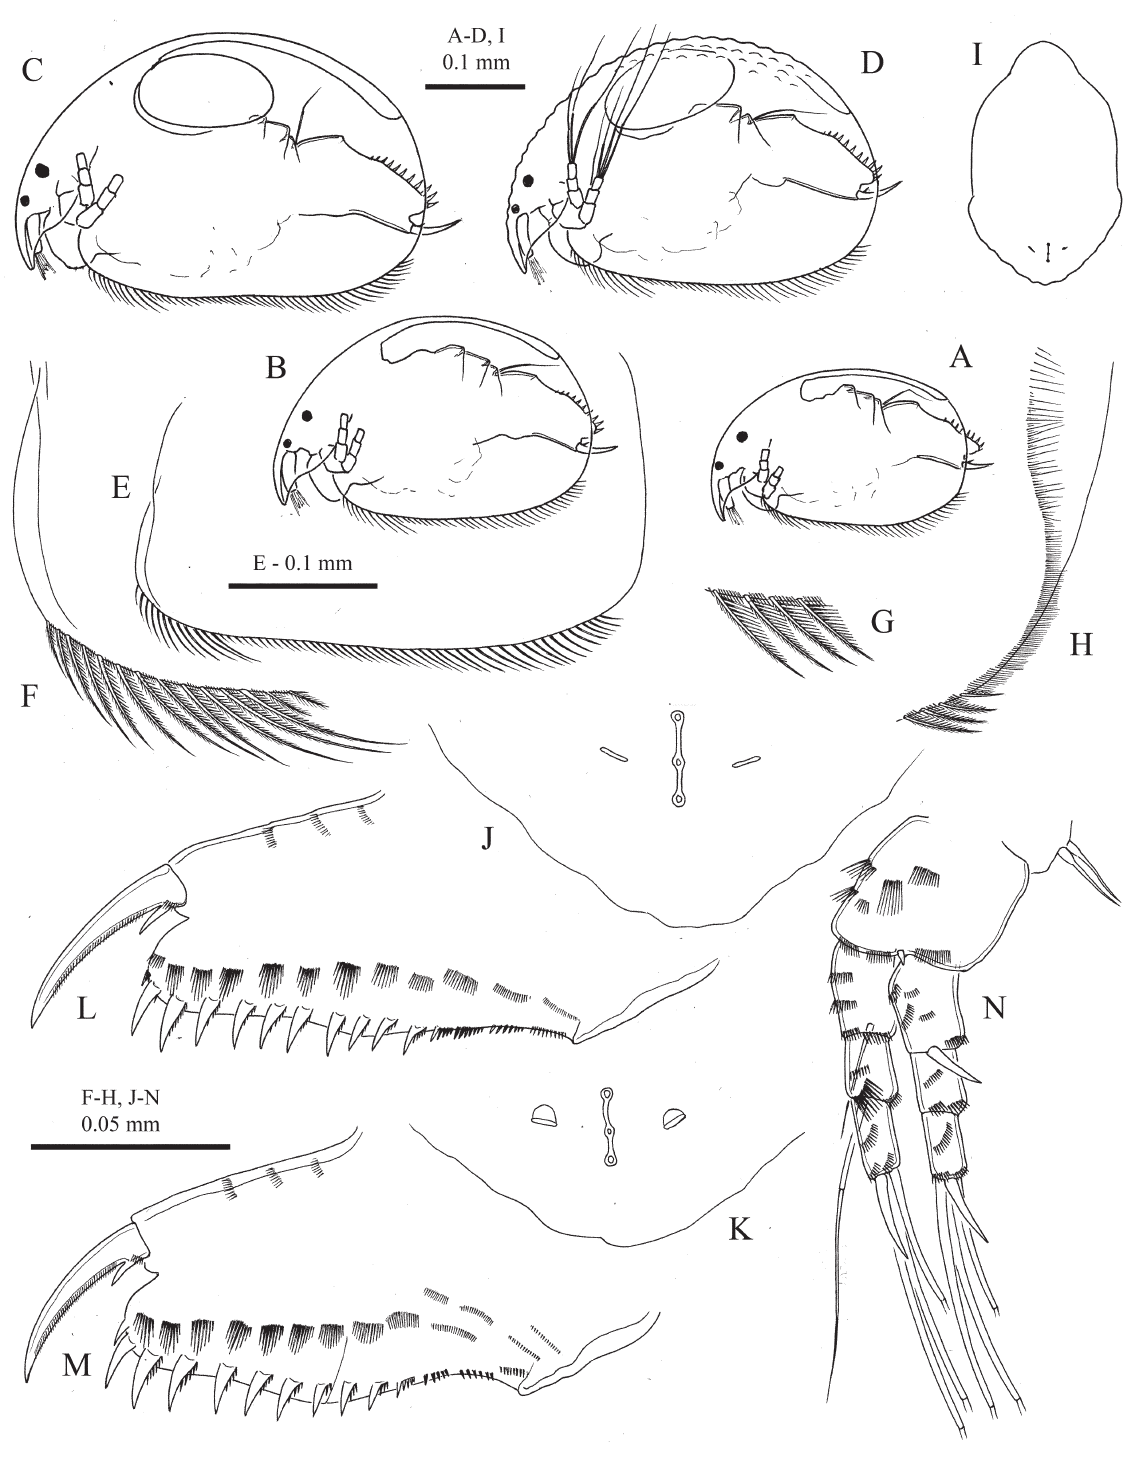
Fig. 4. Flavalona rustica (Scott, 1895) comb. nov. from Bol’shoe Torfyanoe lake, Bolshoi Solovetskiy Island (White Sea), Russia. A–B . Juvenile ♀♀ of instars I and II. C–N . Parthenogenetic ♀. C . Specimen with oblique valves. D . Specimen with tuberculated valves. E . Ventral margin of valves. F . Anterior setae of valves. G . Posterior setae of valves. H . Posteroventral corner and posterior margin of valves. I . Head shield. J–K . Head pores. L–M . Postabdomen. N .